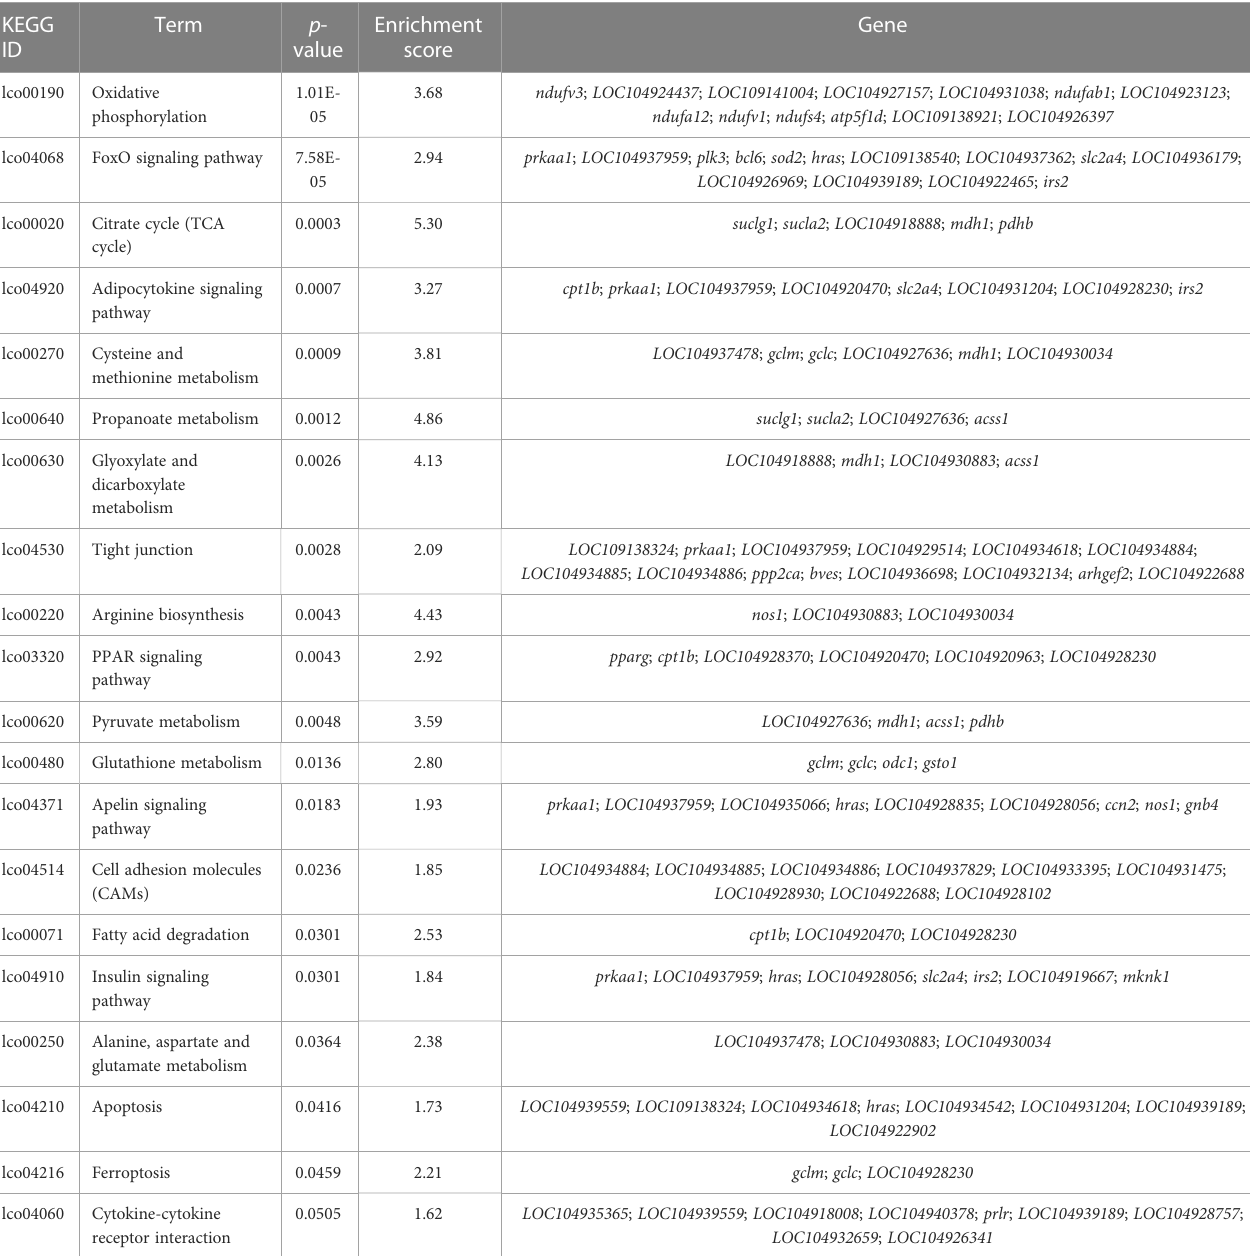
TABLE 7 KEGG enrichment of the overlapped DMRs target DMGs in gills of large yellow croaker under low-salinity